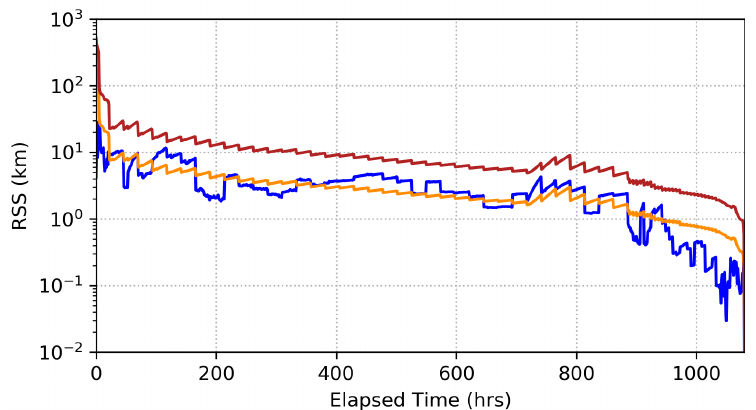
Figure 5. Position error (blue) and RTPC uncertainty (1- σ (orange) and 3- σ (red)) for fused filter in the no-biasing setup.